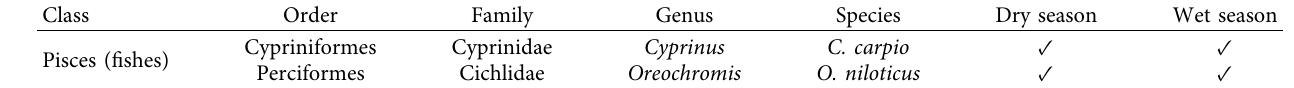
Table 1: Taxonomy of fish species in Lake Maybahr in dry and wet seasons.